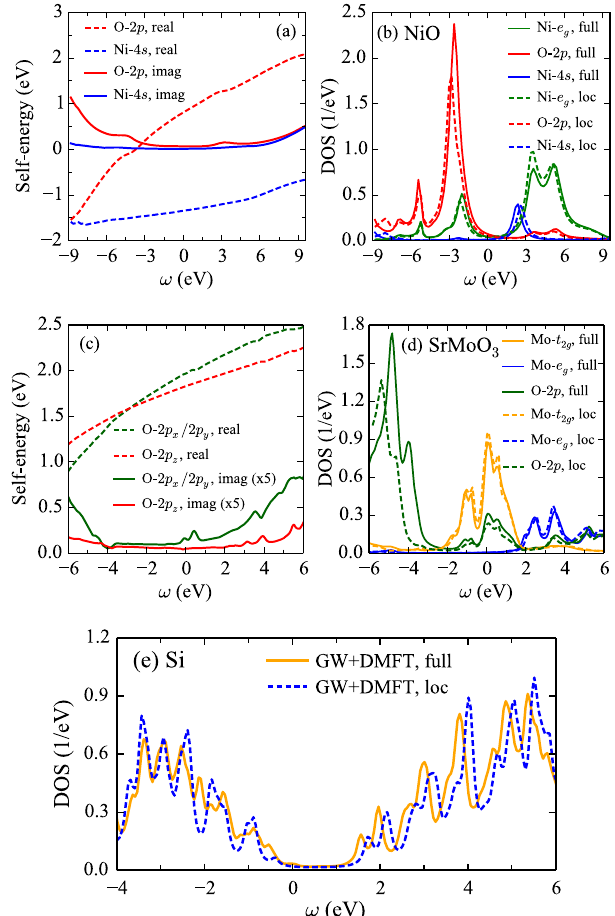
FIG. 7. Effects of non- d -orbital vertex corrections to the self- energy ( Σ CC − Σ GW ) on the full cell GW þ DMFT